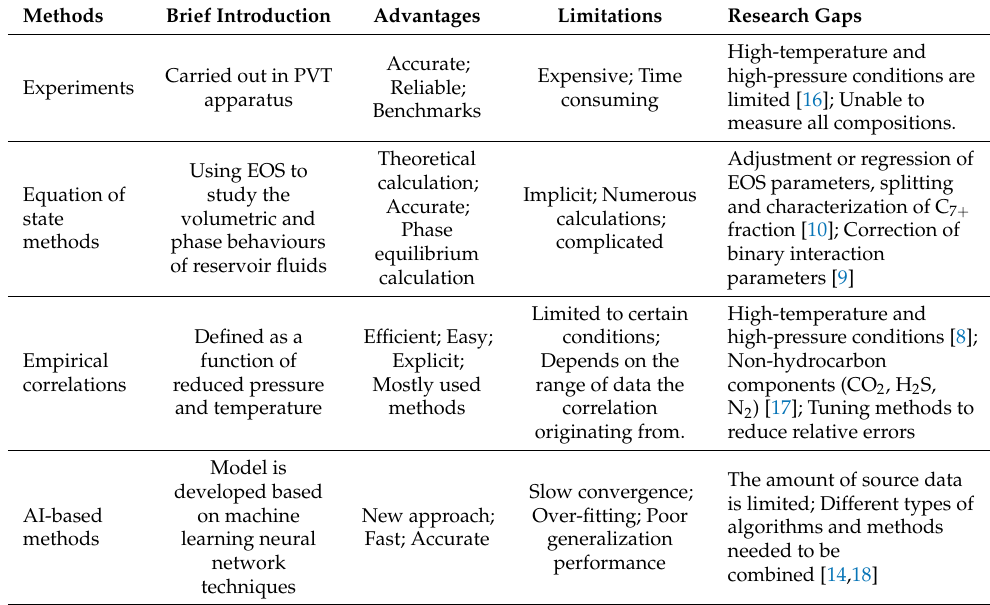
Table 1. The characteristics of current research in the literature of computing compressibility